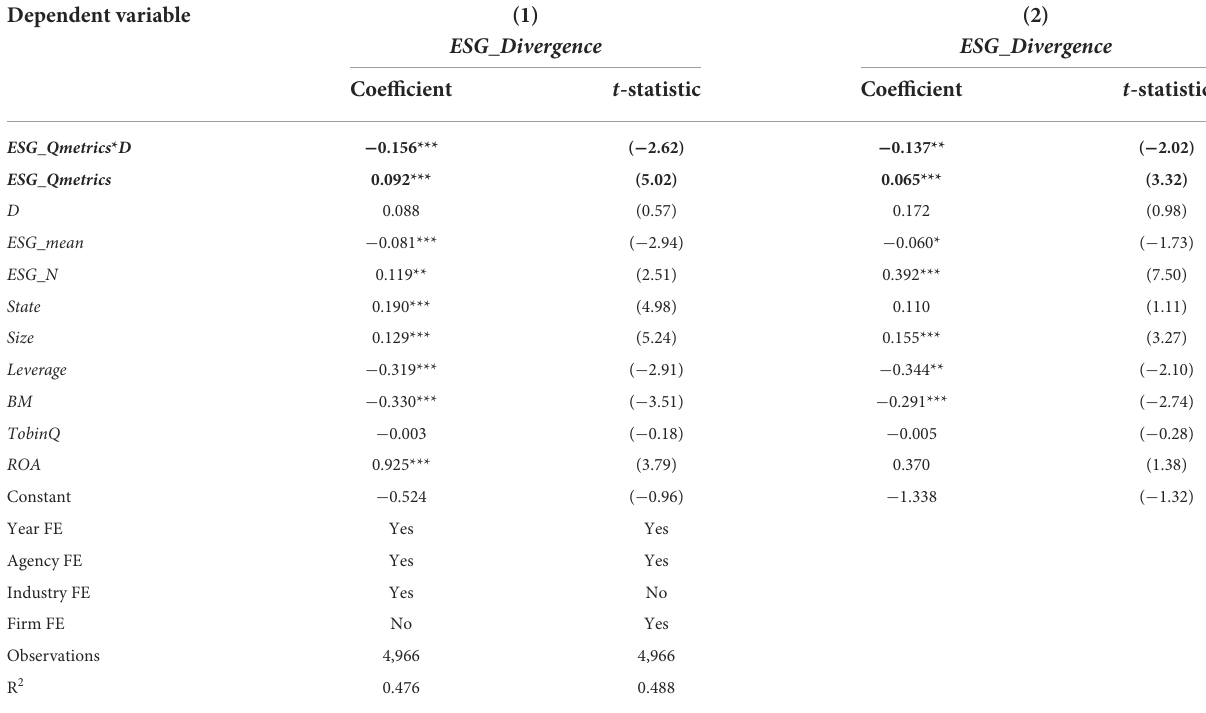
TABLE 5 Effect of standardized quantitative ESG disclosure on ratings divergence: using the shock of disclosure guidance in HKEX. Dependent